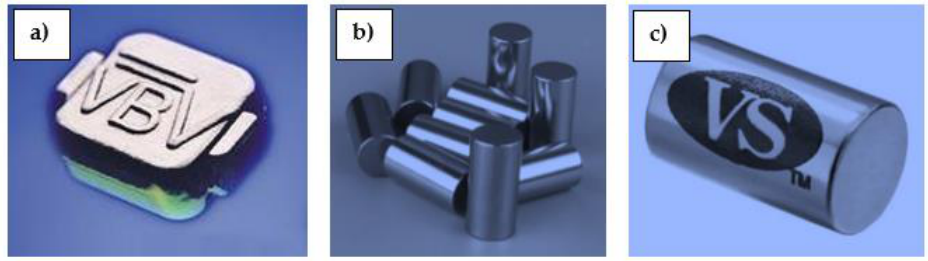
Figure 2. The commercial aspect of the analyzed samples: ( a ) VeraBond, ( b ) Kera N, ( c )